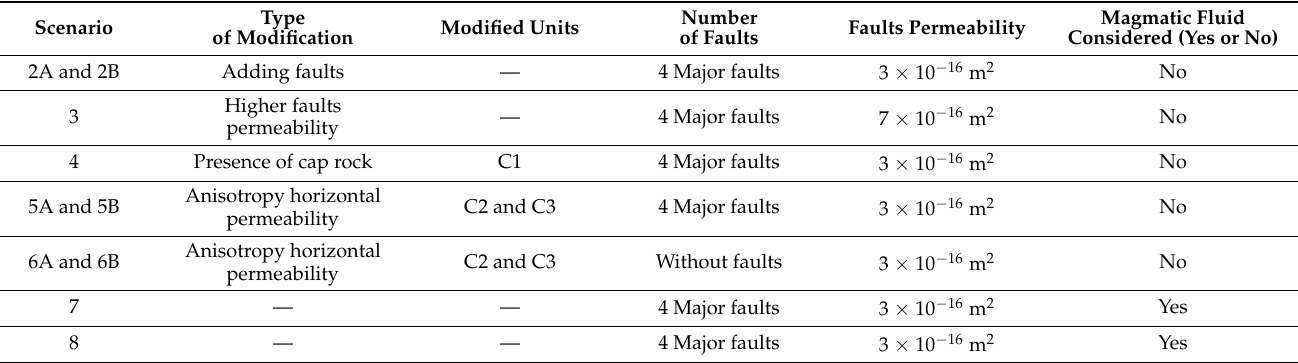
Table 2. Modification of each different scenario from the base case scenario